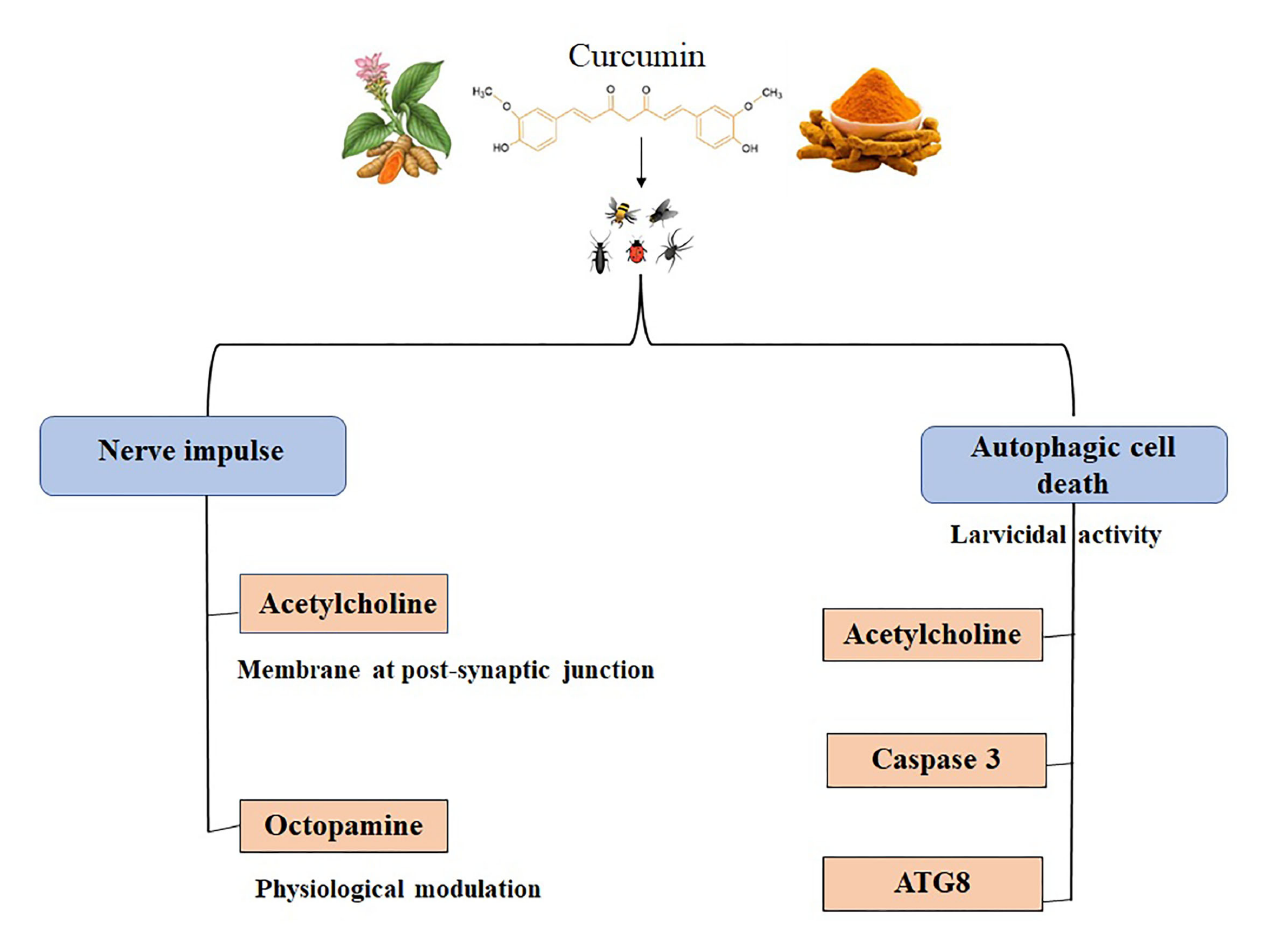
FIGURE3 Insecticidal effects of curcumin. Acetylcholine and octopamine are the neurotransmitters in insects affected by curcumin, leading to blockage of nerve impulse. Acetylcholine, caspase 3, and ATG8 are targeted while curcumin induces autophagic cell death in insect larvae (123, 124, 128).